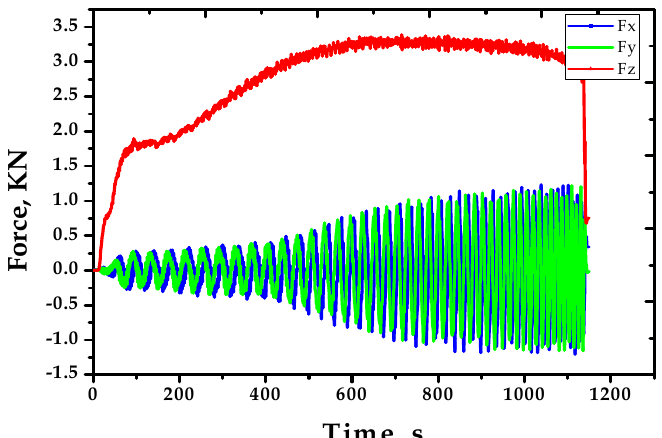
Figure 11. The forming forces in the three directions for the cone produced with run 2, ( F z-p max. = 3.8126 kN).